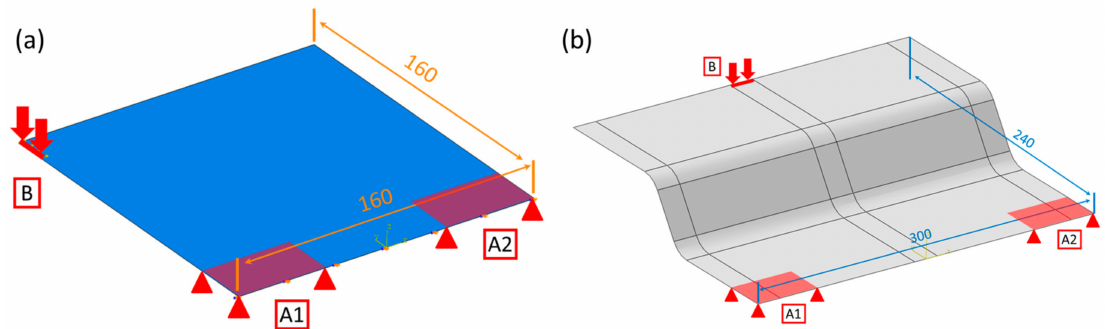
Figure 9. Loading conditions and geometrical dimensions of the optimization test cases: Flat plate with bending load ( a ) and curved structure with bending load ( b ), boundary conditions are represented by the red areas (A1 and A2).